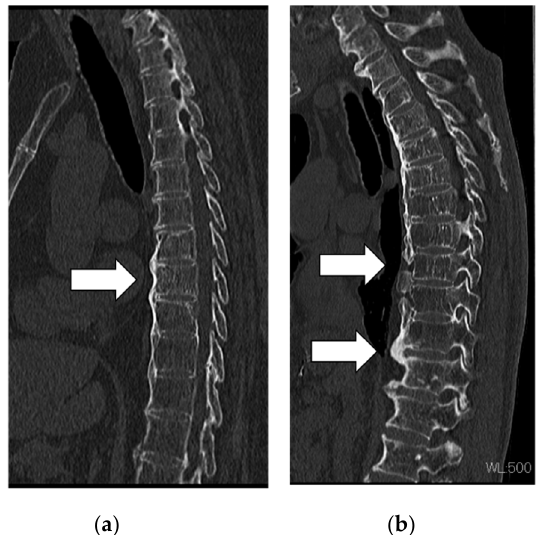
Figure 1. Actual ossified morphology of diffuse idiopathic skeletal hyperostosis. Images from a patient showing ( a ) flat ossification and ( b ) large and discontinuous ossification.